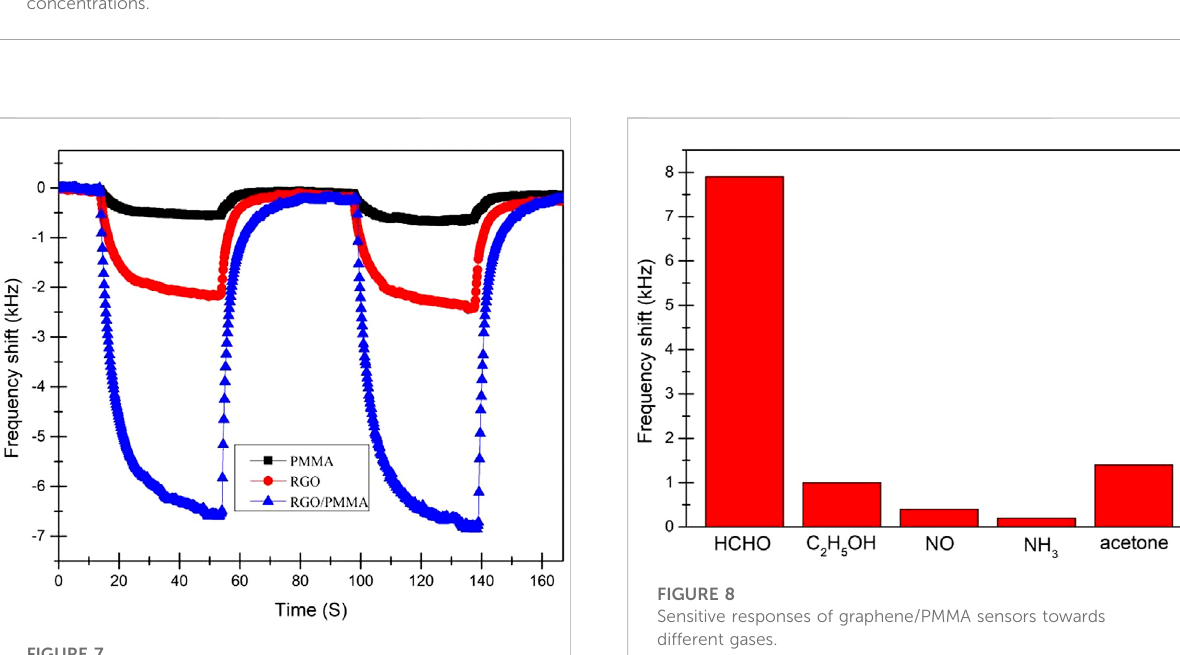
FIGURE 7 Sensitive responses of SAW sensors using pure PMMA, pure graphene and graphene/PMMA composite exposed to 4.0 ppm formaldehyde.